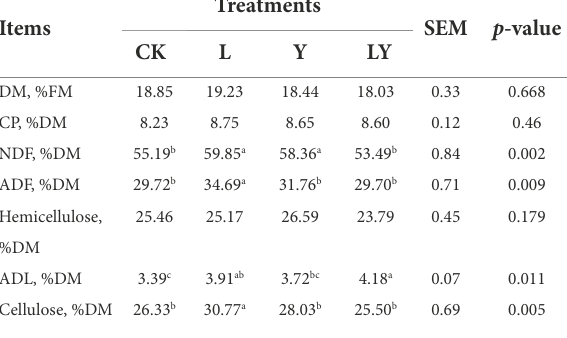
TABLE 2 Chemical composition of cellulase-treated Pennisetum sinese (CTPS) after 60 days of anaerobic fermentation.